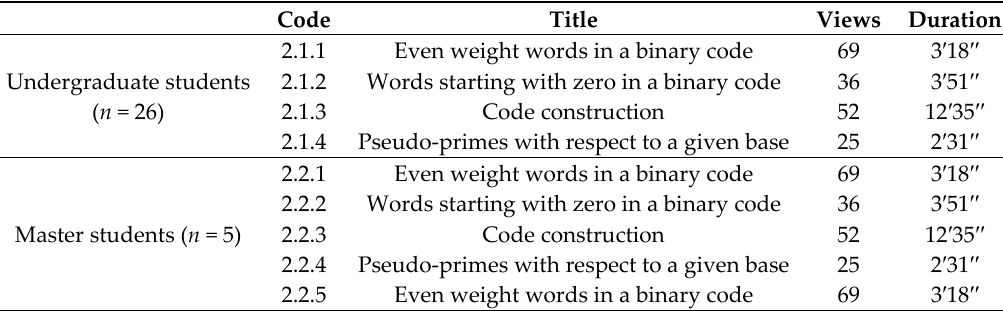
Table 1. Views and durations of the